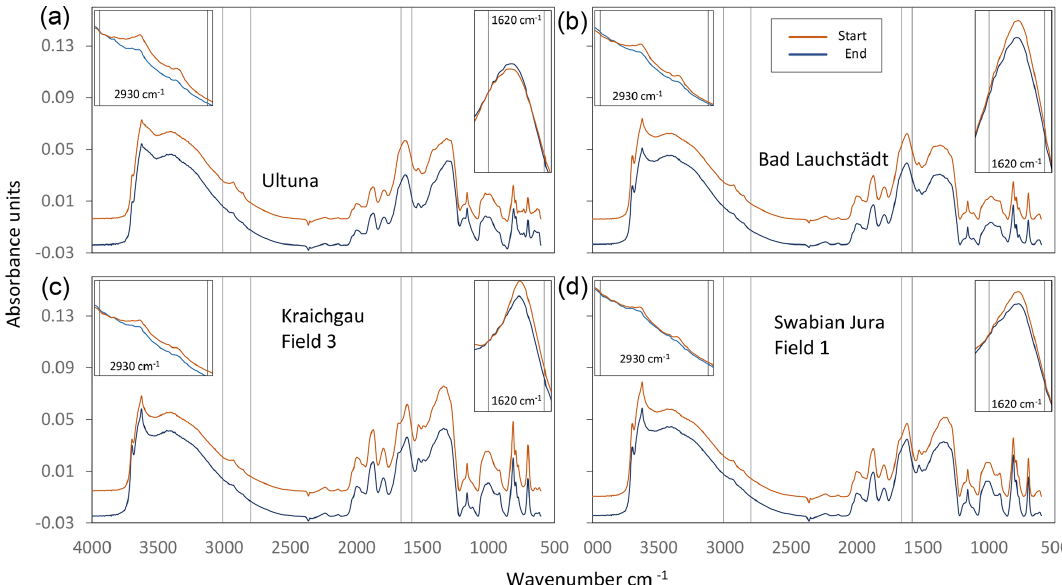
Figure 2. Examples of baseline-corrected and vector-normalized DRIFTS spectra of bulk soil samples (dried at 105 ◦ C) of the first and last year of the bare fallow plots at four sites. Fallow periods were 50 years ( a Ultuna), 24 years ( b Bad Lauchstädt) and 7 years ( c Kraichgau and d Swabian Jura). Small pictures in (a) to (d) are zoomed-in versions of the 2930cm − 1 band (left) and the 1620cm − 1 band (right). For better visibility, the full spectra pictures have a y -axis offset ( + 0.02 for samples from the start), while zoomed-in versions share a common baseline. More details on the sites are in Table